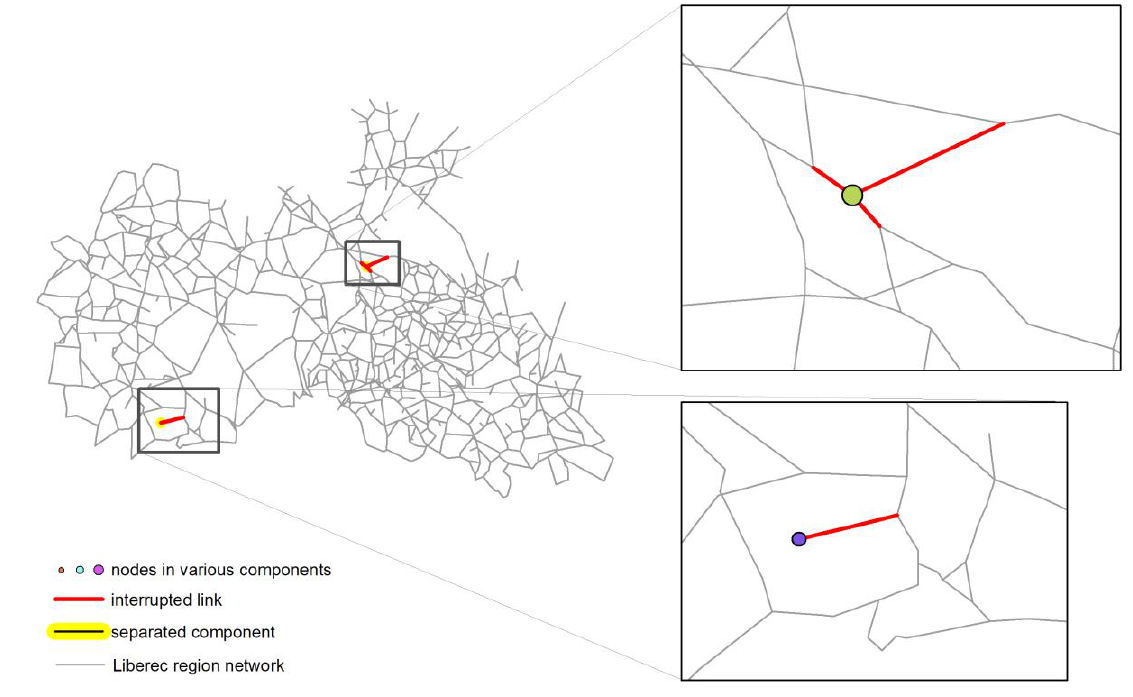
Figure 6. The worst scenario found by ANSA for four concurrently interrupted road links in the Liberec region network. 17,140 people (3.98%) cut off from the main